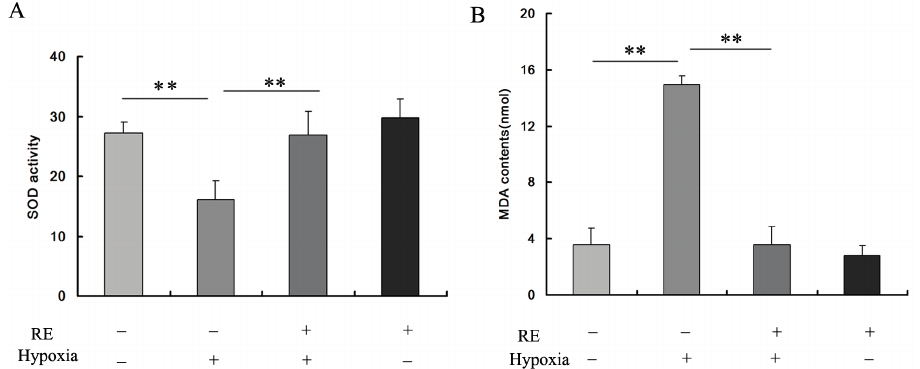
Figure 2. Assays for SOD and MDA in HTR-8/SVneo cells treated under hypoxia and resveratrol. ( A ) After culture in hypoxic conditions for 24 h, HTR-8/SVneo cells exhibited significant inhibition of SOD activity, and this inhibition was rescued by resveratrol supplementation. ( B ) MDA contents were increased after hypoxic culture and reversed by resveratrol. Values are mean ± SD; ** p < 0.01.